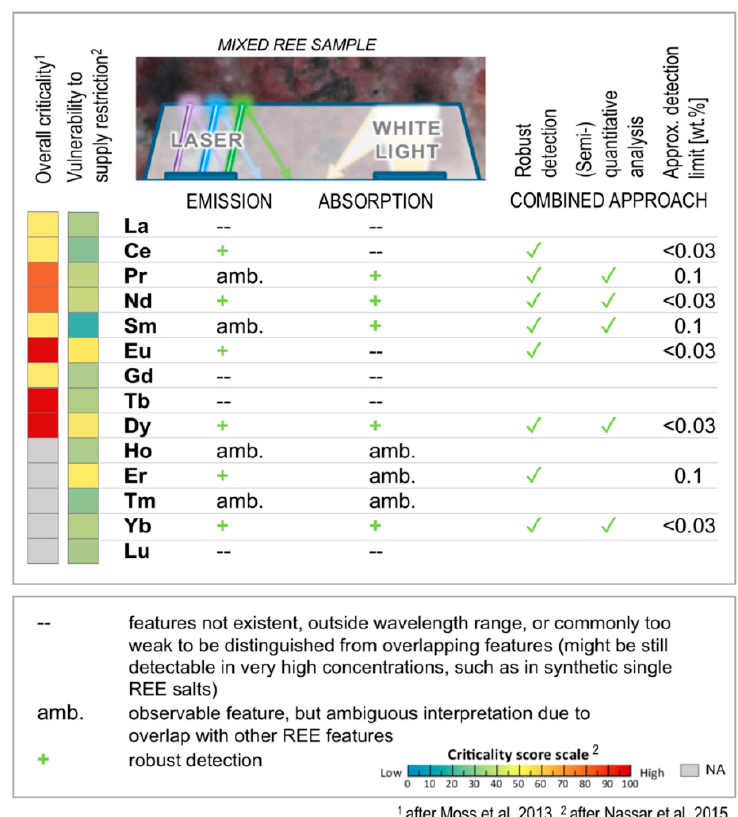
Figure 9. Overview on the performance of the employed reflectance and PL approaches for the detection of REE and the possibilities of a combined approach. A comparison of detectability with criticality and vulnerability to supply restrictions of the individual REE shows the economic value of the presented approach (NA: no data available).